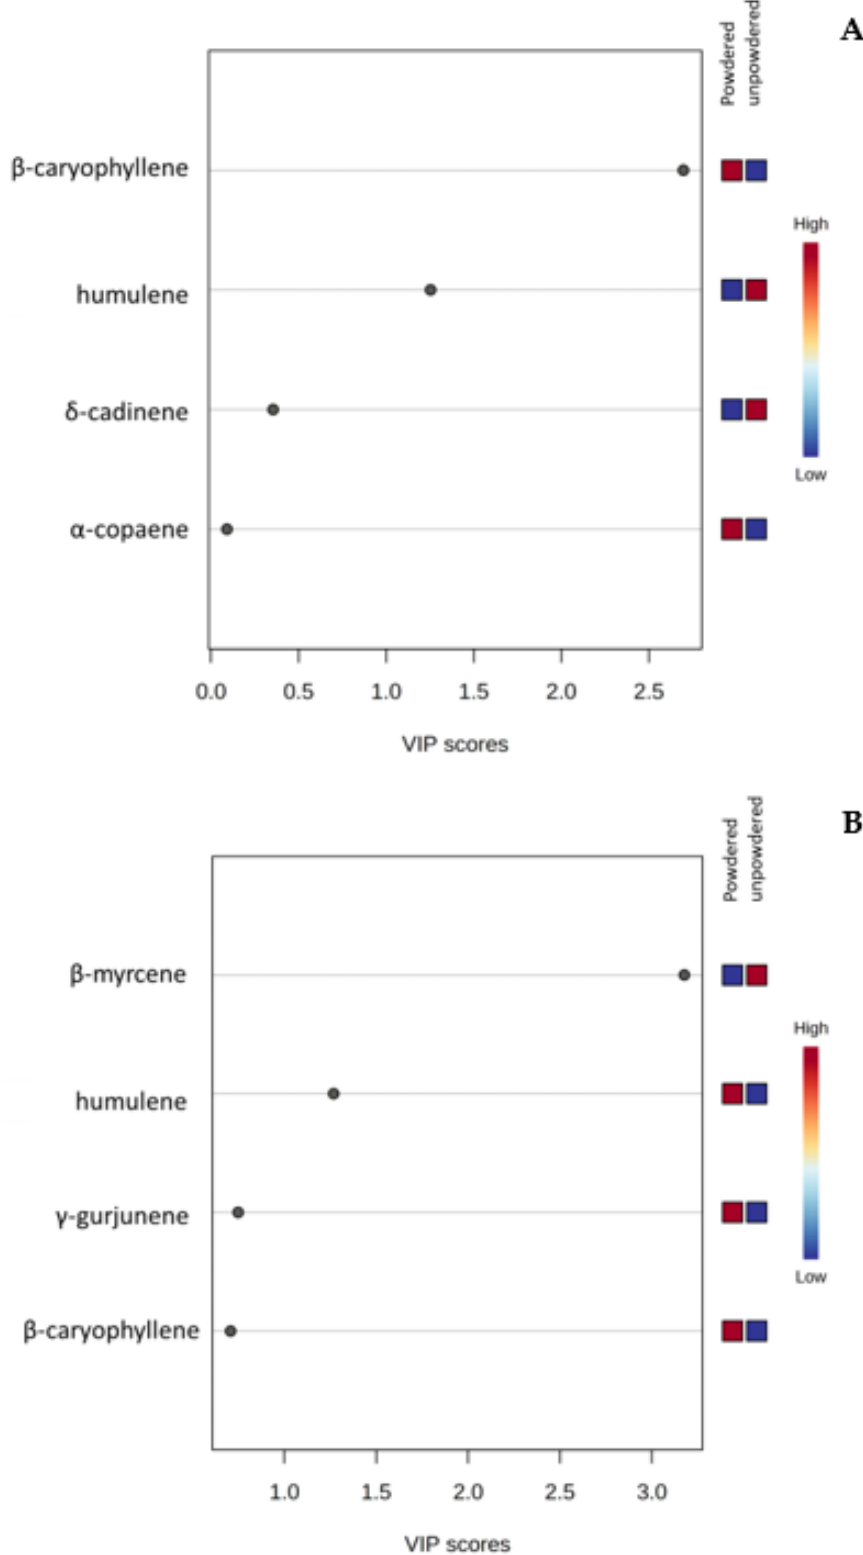
Figure 3. ( A ) VIP plot on powdered/unpowdered fresh leaves; ( B ) VIP plot on powdered/unpowdered fresh inflorescences. fresh